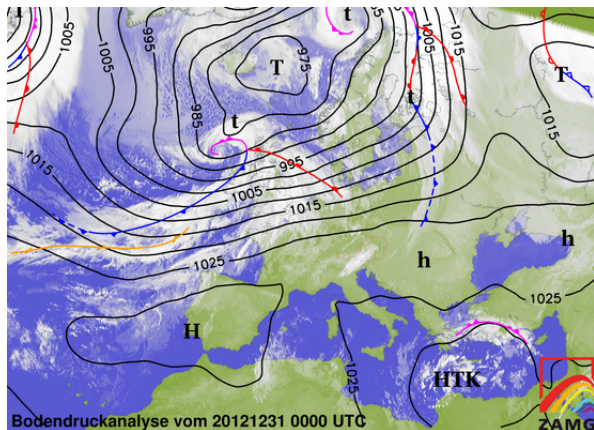
Figure 2. Frontal analysis chart with mean sea level pressure and satellite imagery for Europe on 31 December 2012, 00:00UTC.